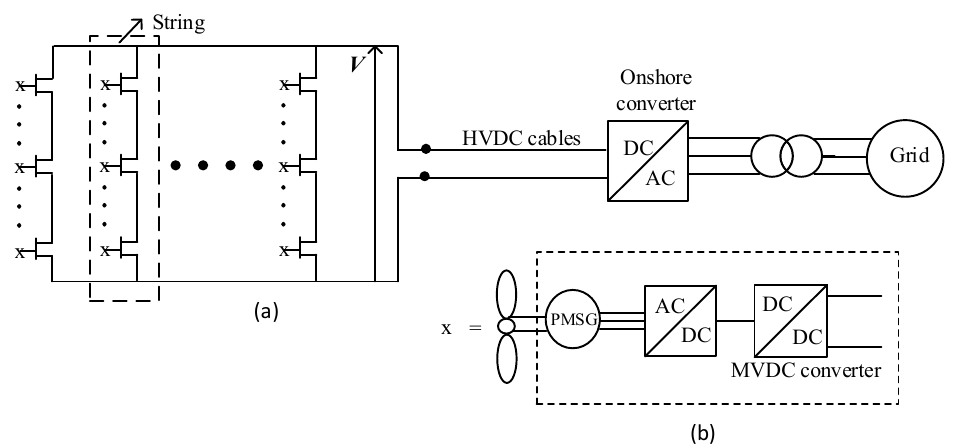
Figure 1. ( a ) DC series–parallel collection system. ( b ) Generators and power conversion components in an individual wind turbine.